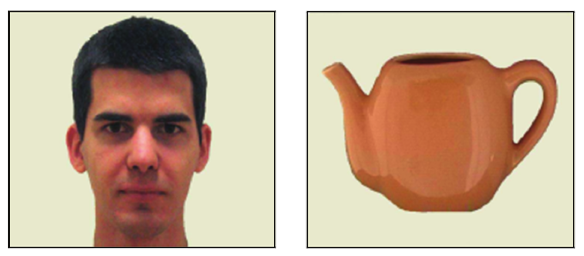
Figure 1: The two types of visual stimuli: neutral faces and